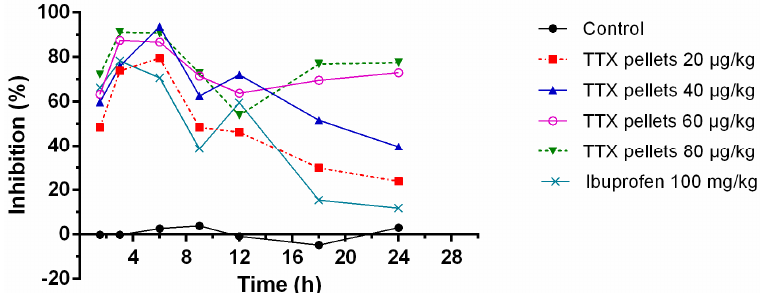
Figure 6. The percentage of inhibition of sustained-release TTX pellets on writhing test. Saline, TTX formulation or ibuprofen was i.g. administrated at 0 h. Then, 0.6% acetic acid solution (10 mL/kg, intraperitoneally) was administrated at different time points (1.5 h, 3 h, 6 h, 9 h, 12 h, 18 h and 24 h). At each time point, the number of writhing during a 30-min duration following acetic acid solution injection was counted and recorded. Data are expressed as mean ( n = 10).